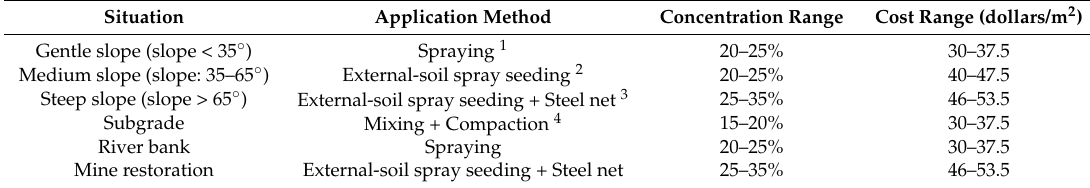
Table 6. The application of PVAc in different situations .